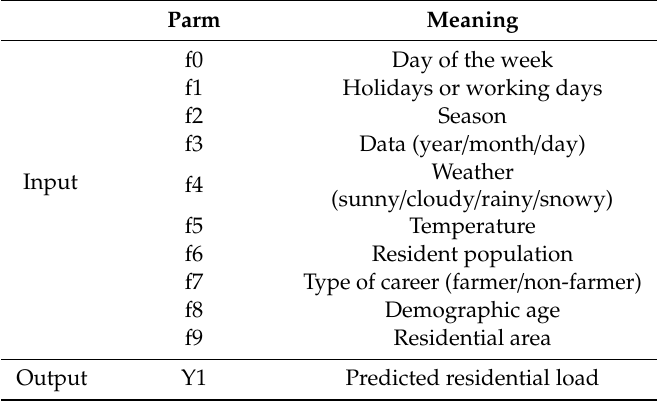
Table 1. Sample data of residential load forecasting.